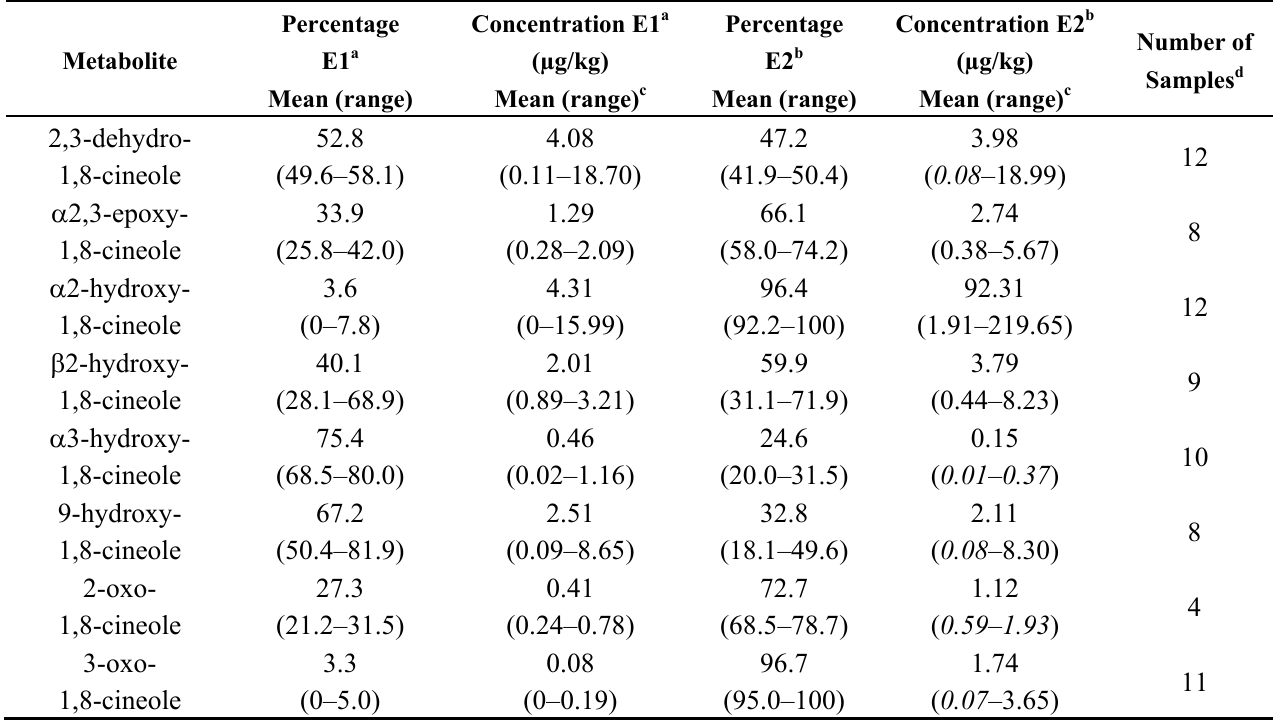
Table 3. Ratios of enantiomers and their absolute concentration for chiral metabolites of 1,8-cineole in human